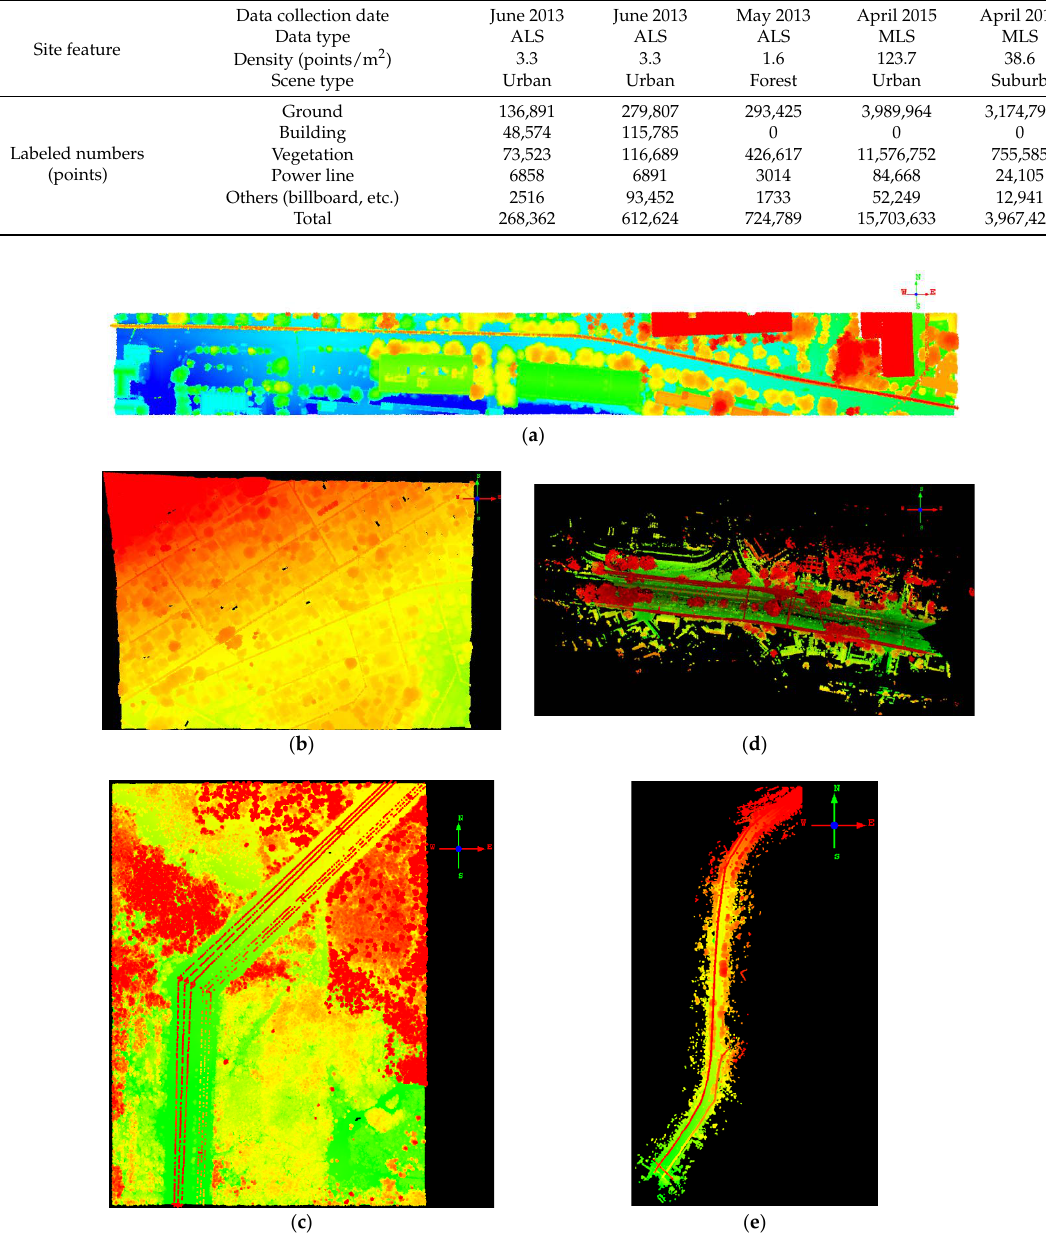
Figure 2. Visualization of the experimental datasets. ( a ) The site I dataset from the large urban ALS (airborne laser scanning) scene around the campus of the University of Hawaii; ( b ) the site II dataset from the large urban ALS scene surrounding the campus of University of Hawaii; ( c ) the site III dataset from the forest ALS scene in Minnesota; ( d ) the site IV dataset of MLS (mobile laser scanning) along primary roads located in Honolulu; ( e ) the site V dataset of MLS along primary roads located in